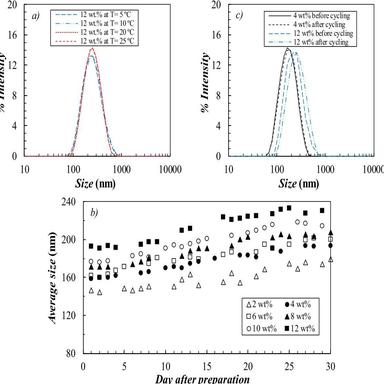
(a) Temperature, (b) temporal and (c) freeze− thaw stability assessments based on dynamic light scattering measurements for O/W nanoemulsions composed of a dispersed phase mixture (2–12 wt%) enriched in methyl myristate. Results obtained at T = 25 ◦C unless otherwise indicated.